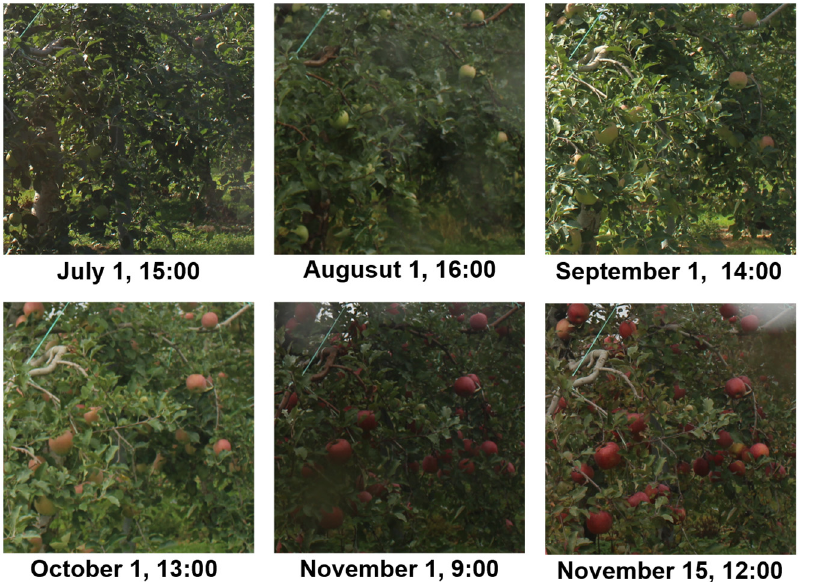
Sensors 2022 , 22 , x FOR PEER REVIEW 9 of 21 the growth curve predictions, the accuracy for radius detection and real-time prediction